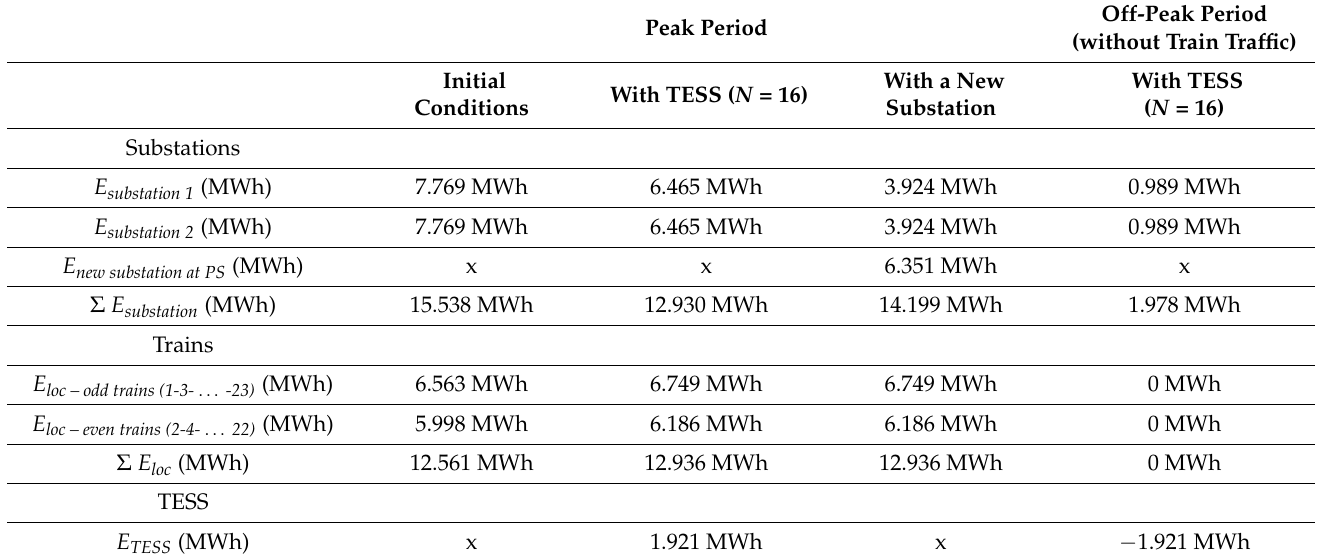
Table 6. Energy balance of the double-track line sector.